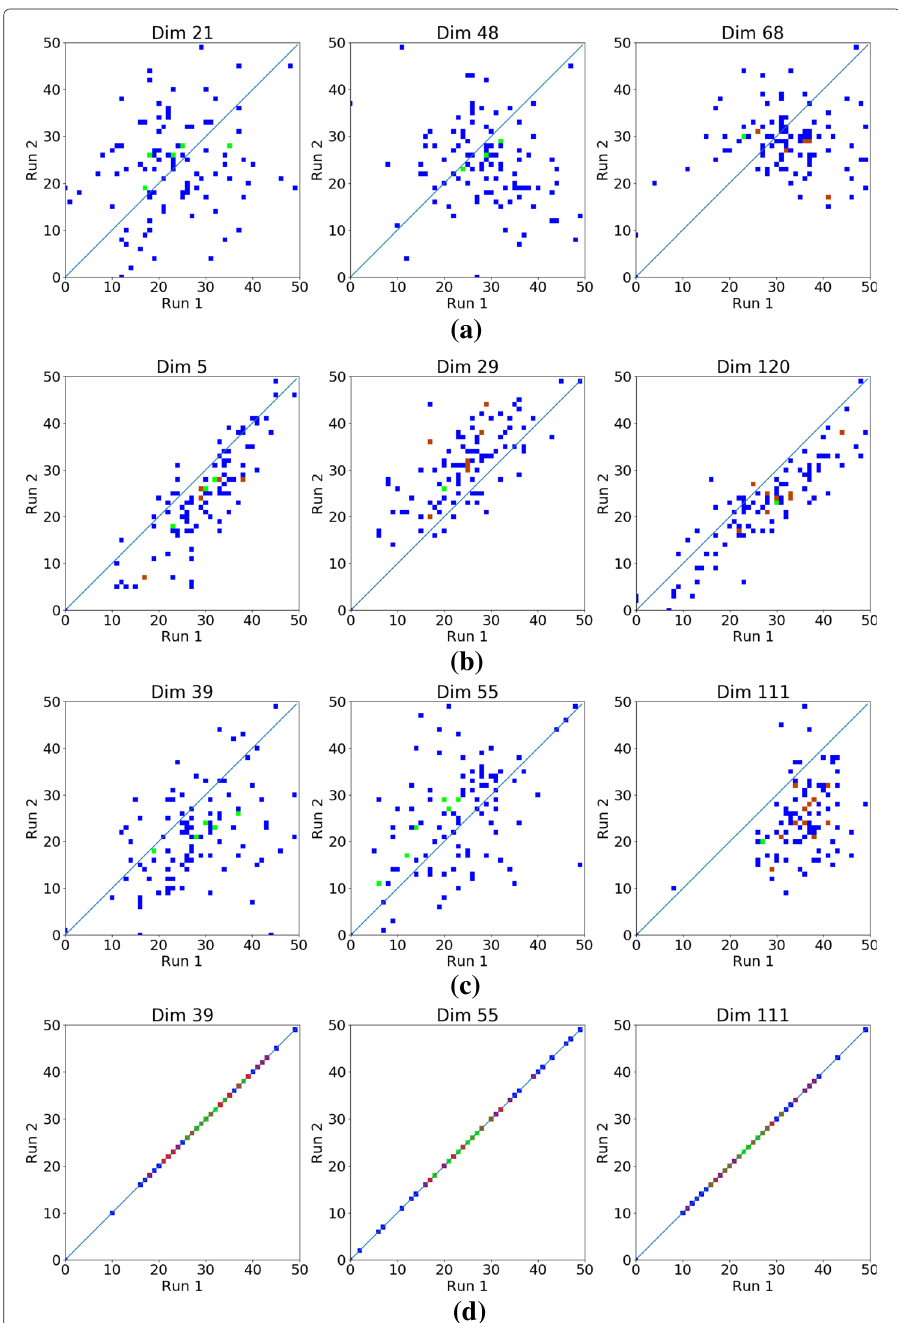
Fig. 4 PPI dataset: Comparison of embeddings per dimension for a random sample of 100 nodes. Node2vec, DeepWalk, Walklets, and SURREAL are run two times. The x -axis represents first run representations values, and the y -axis represents second run representations values. Three dimensions are selected randomly for each algorithm. The SURREAL-based representations are robust across runs (perfectly fall on a straight line y = x ), which is not the case for node2vec, DeepWalk, and Walklets. The results are consistent for all the datasets. ( a ) Node2vec . Dimensions from left: 21, 48, 68 ( b ) DeepWalk . Dimensions from left: 5, 29, 120 ( c ) Walklets . Dimensions from left: 39, 55, 111 ( d ) SURREAL . Dimensions from left: 39, 55,